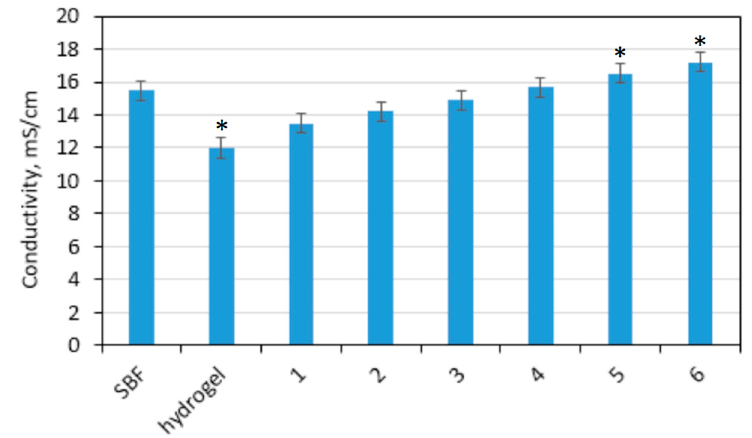
Figure 4. Conductivity of the prepared transdermal systems: (1) CS-ZnO-1; (2) CS-ZnO-2; (3) CS-ZnO-3; (4) CS-ZnO-4; (5) CS-ZnO-5; and (6) CS-ZnO-6. (* p < 0.05).